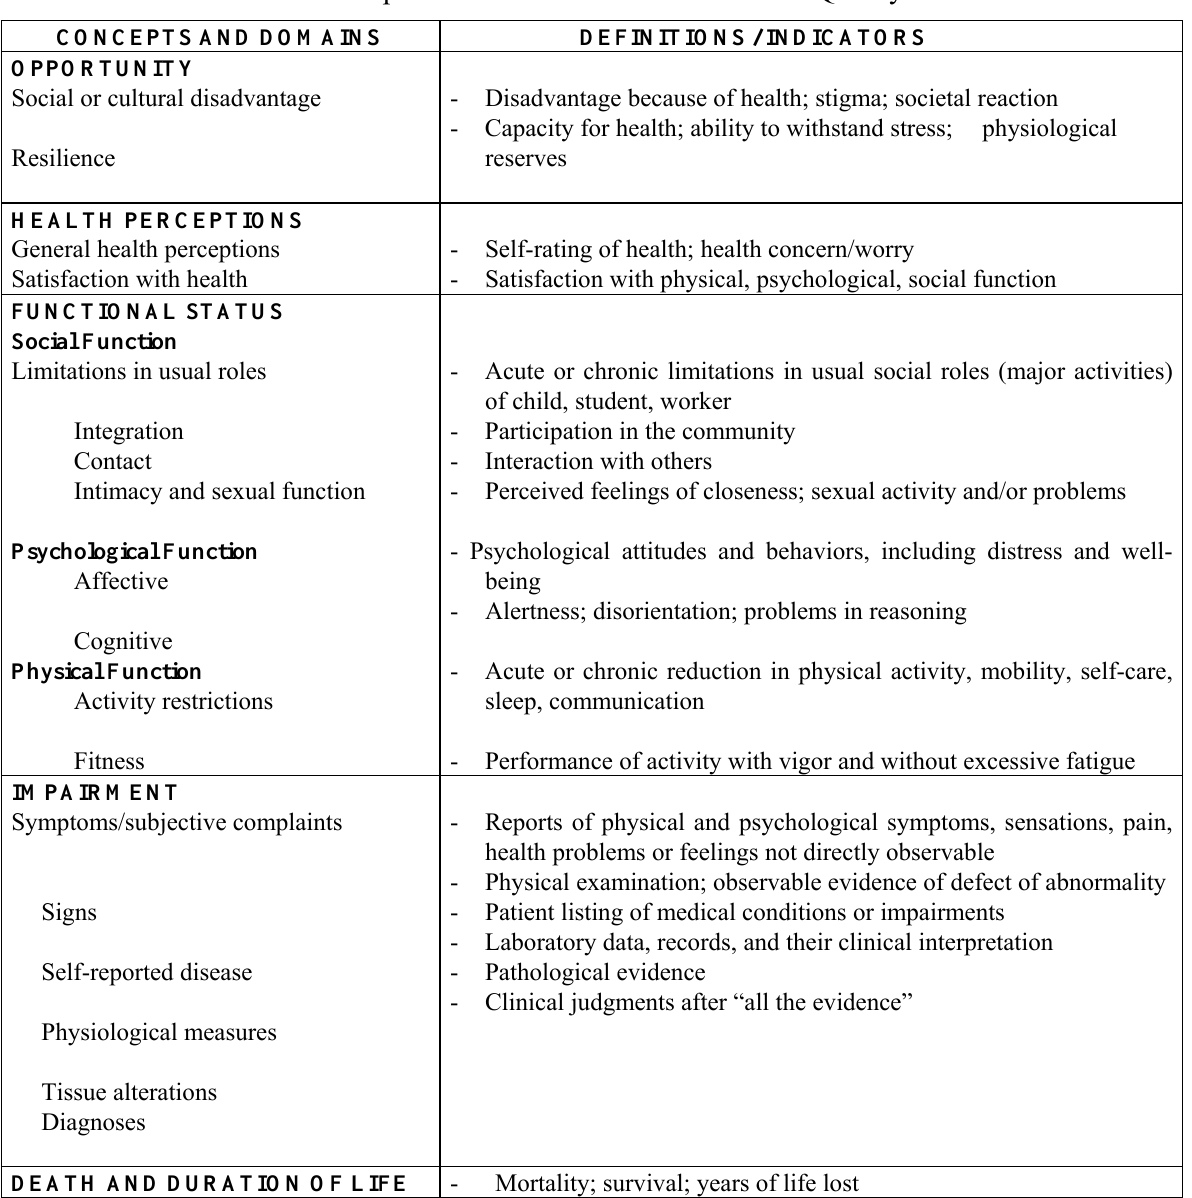
Table 1. Core Concepts and Domains of Health-Related Quality of